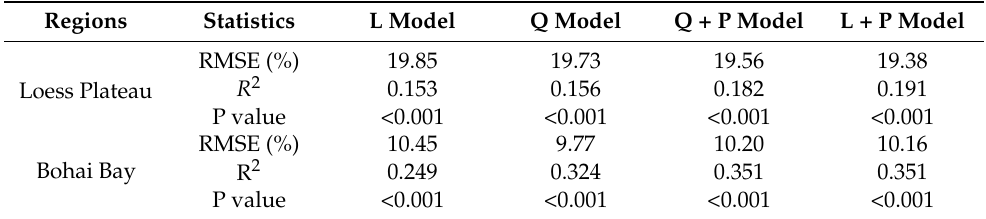
Table 2. Evaluation indicators of the four kinds of relationship models between apple yield and K application rates. Regions